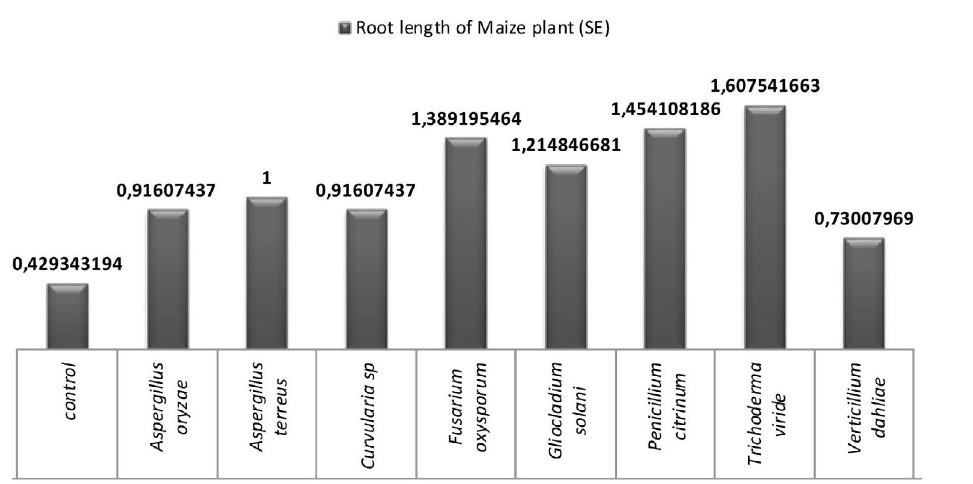
Fig. 7. Influence of endophytic fungal crude extracts on root growth of maize